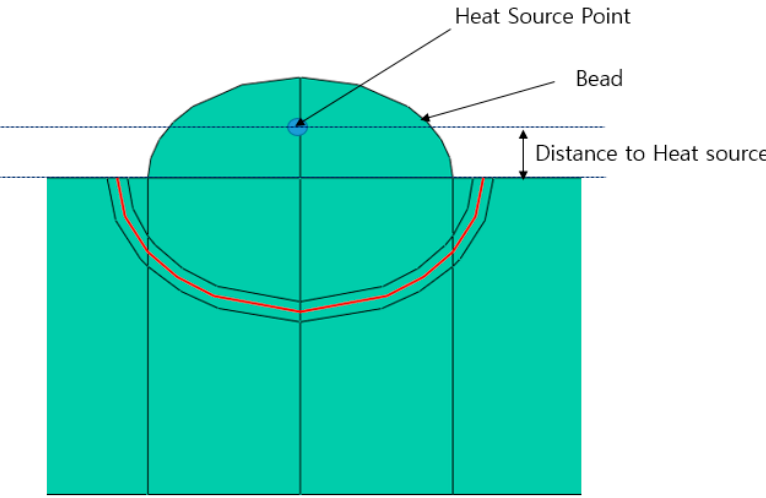
Figure 2. Definition of the heat source point.